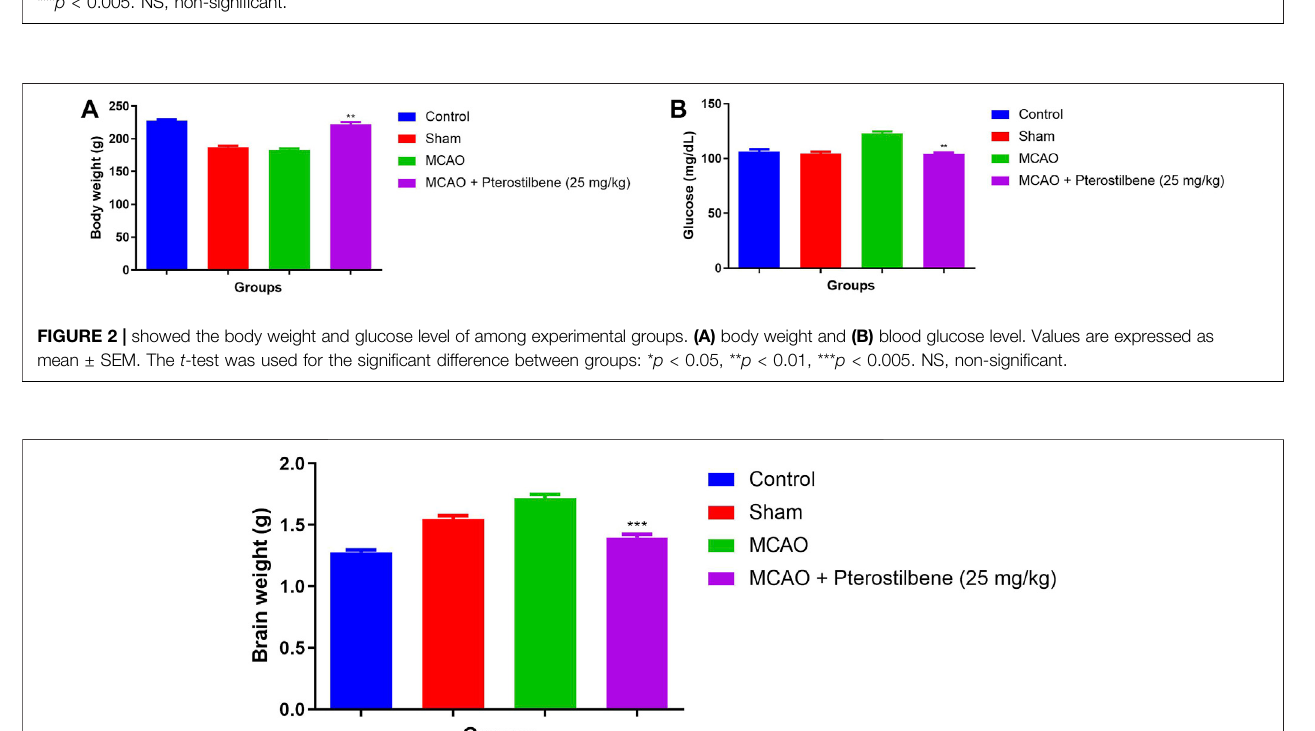
CAT (28.85 ± 1.33 U/mg protein), GPx (33.73 ± 4.34 U/mg protein), GSH (1.34 ± 0.45 U/mg protein) and suppressed the level of MDA (89.45 ± 3.45 U/mg protein), 8-OdhG (0.28 ± 0.05 μ g/mg protein).